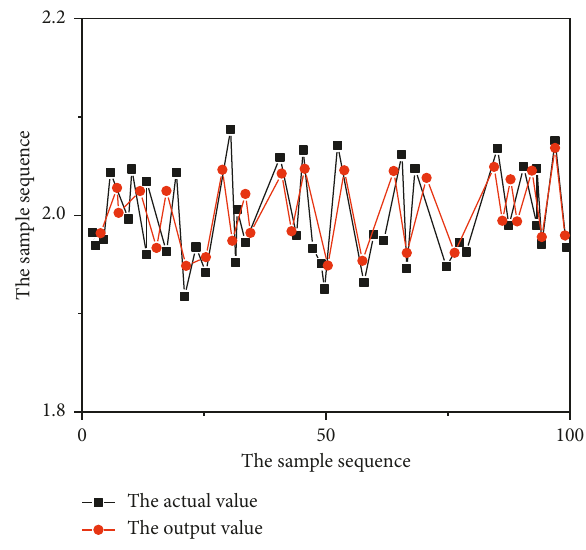
Figure 7: Generalization results of dissolved oxygen mass con- centration soft sensing